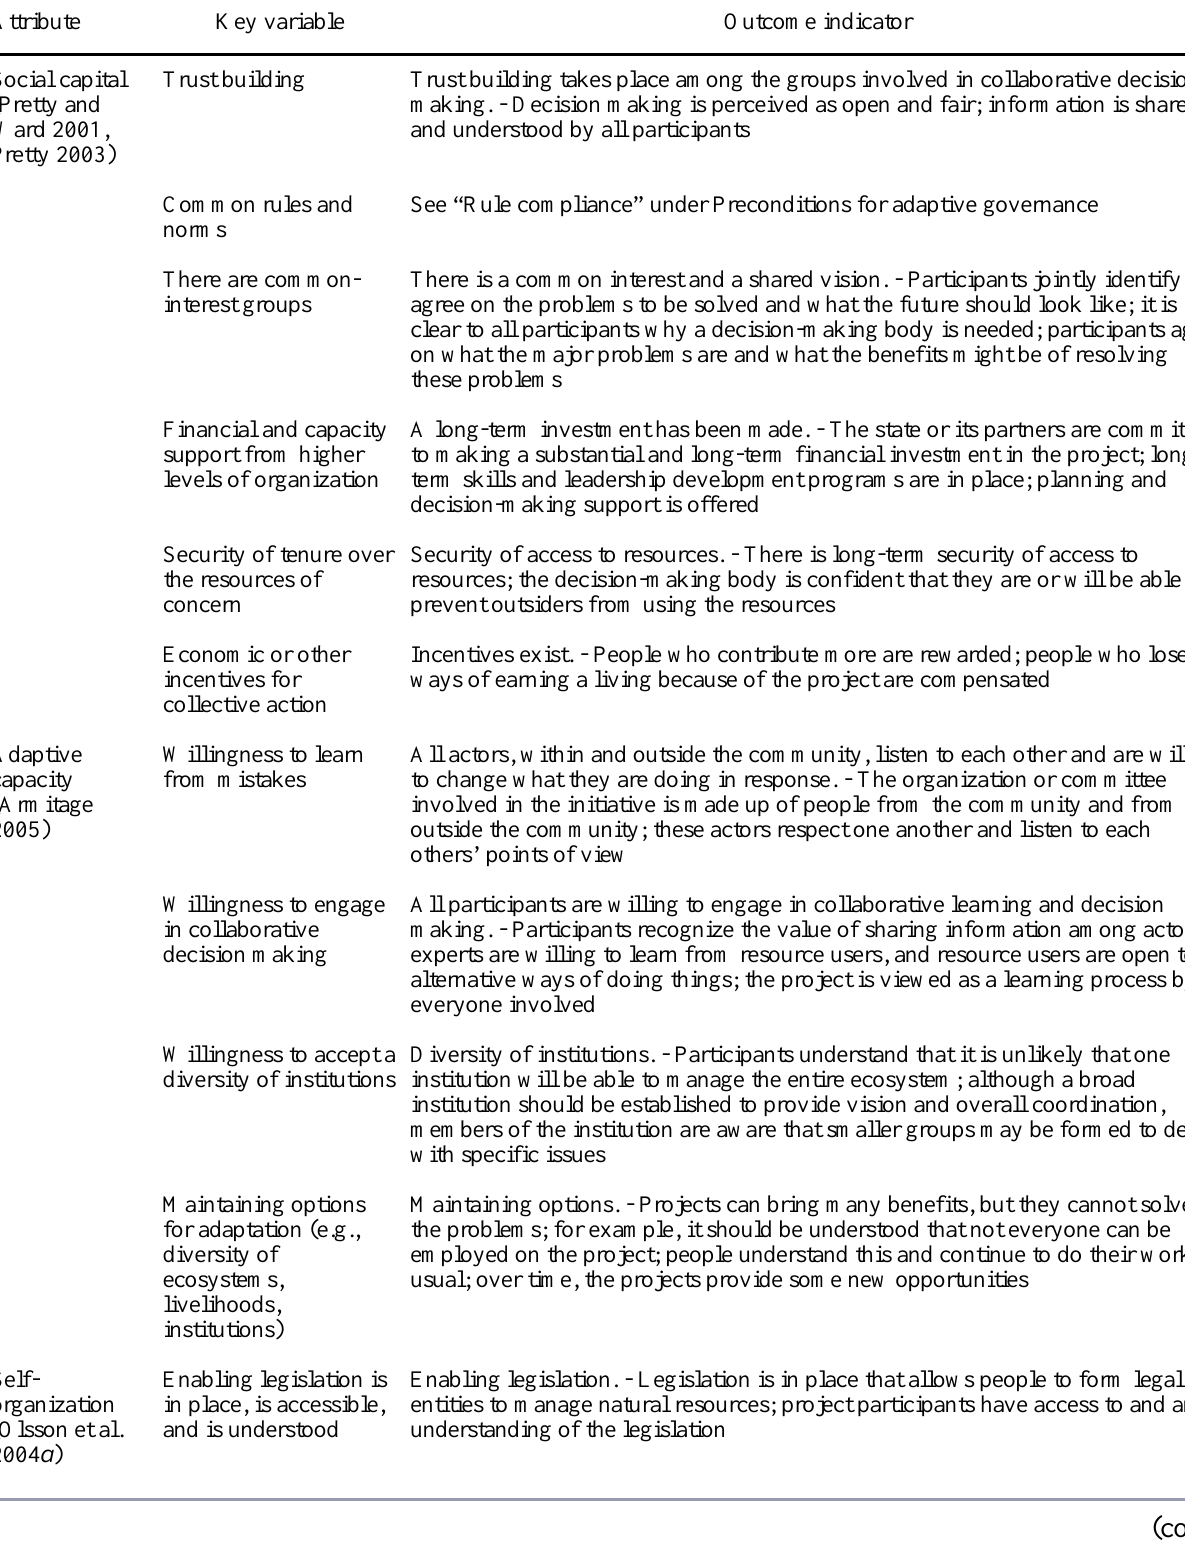
Table 2. Key variables and outcome indicators for collaborative governance monitoring. †